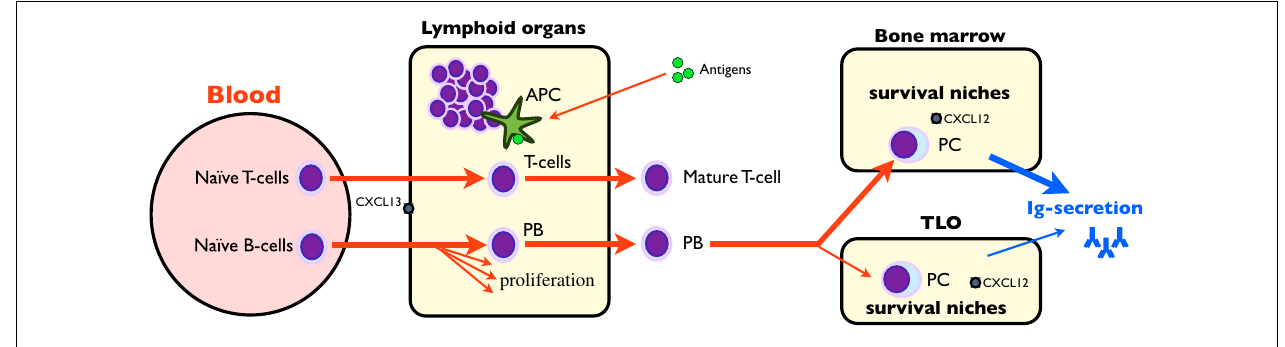
bone marrow, differentiate to long-lived plasma cells (PC), and synthesize the bulk of plasmatic IgG. However, secondary/tertiary lymphoid organs may also retain PC in survival niches, where they participate in IgG